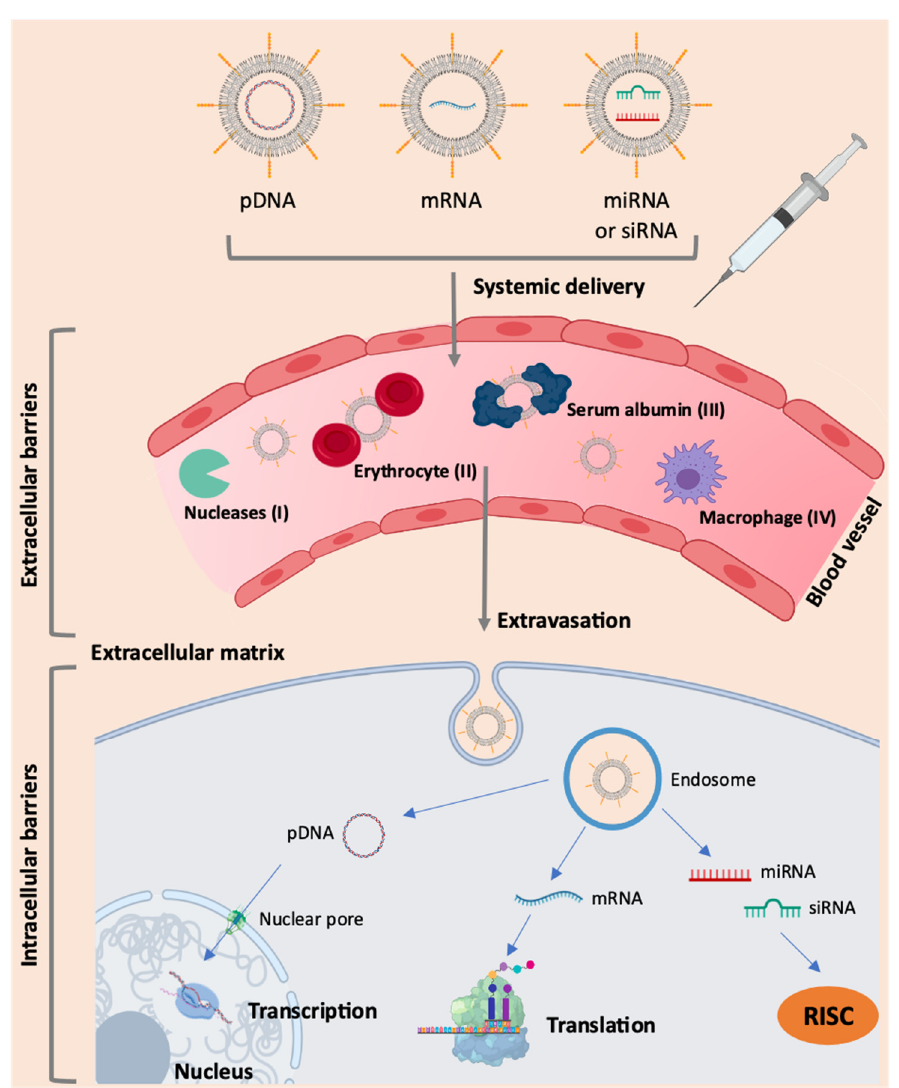
Figure 2. Schematic representation of Extra- and Intracellular Barriers for nucleic acids delivery. (I)—Endo and exonuclease degradation; (II)—Interaction and binding with erythrocytes; (III)—Binding and aggregation via serum protein complexation; (IV)—Immune activation to delivered nucleic acids.